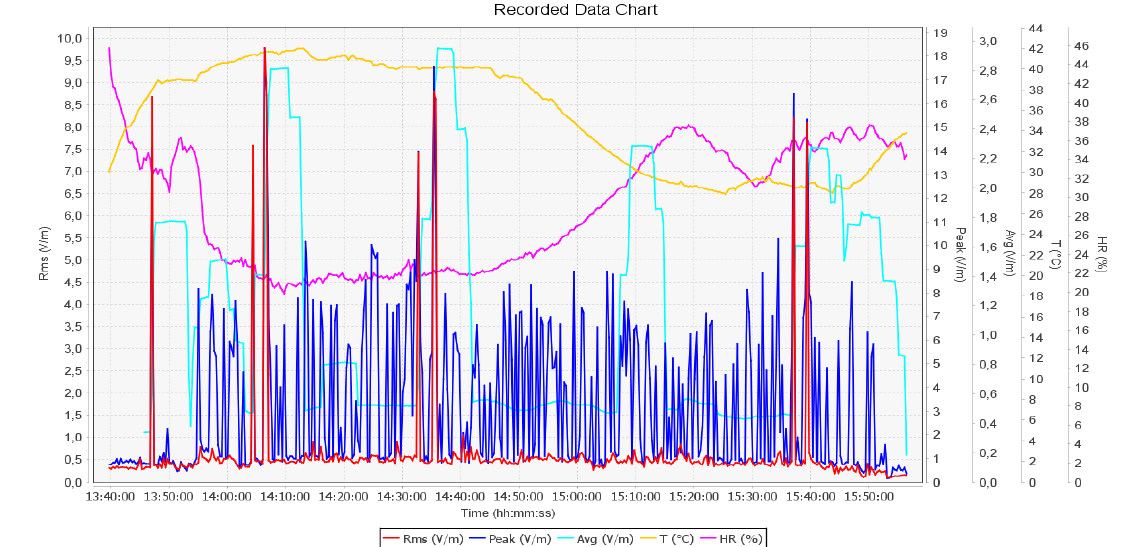
Figure 6. The intensity of the electrical component of the electromagnetic field in the course of flight no. 1 for the Cessna 172.